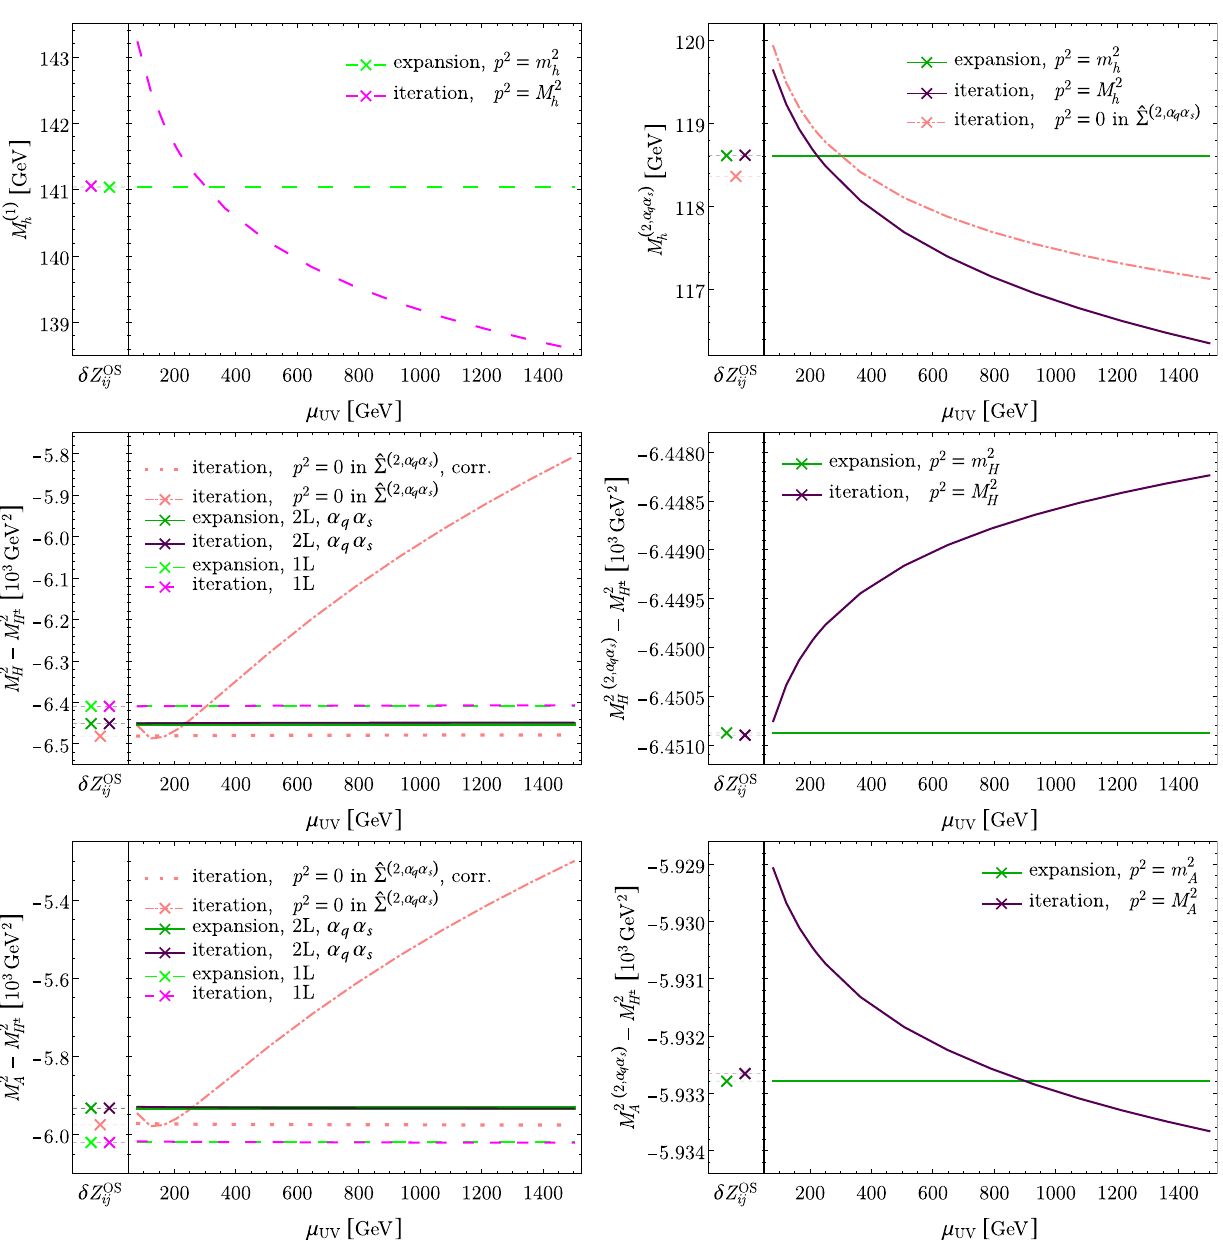
lines represent calculations of O (α q α s ) with full momentum depen- dence: the masses are derived via an expansion (dark green), or an iterative pole search (purple). The crosses in the columns on the left of the plots correspond to the evaluations with OS field counterterms. Up: Mass of the light SM-like state at 1L (left plot; long-dashed curves) and at order α q α s (right). Middle and bottom: Squared mass-splitting betweenthe CP -even(Middle)or CP -odd(Bottom)heavy-doubletstate and the charged Higgs; general perspective (left) and details of the 2L predictions